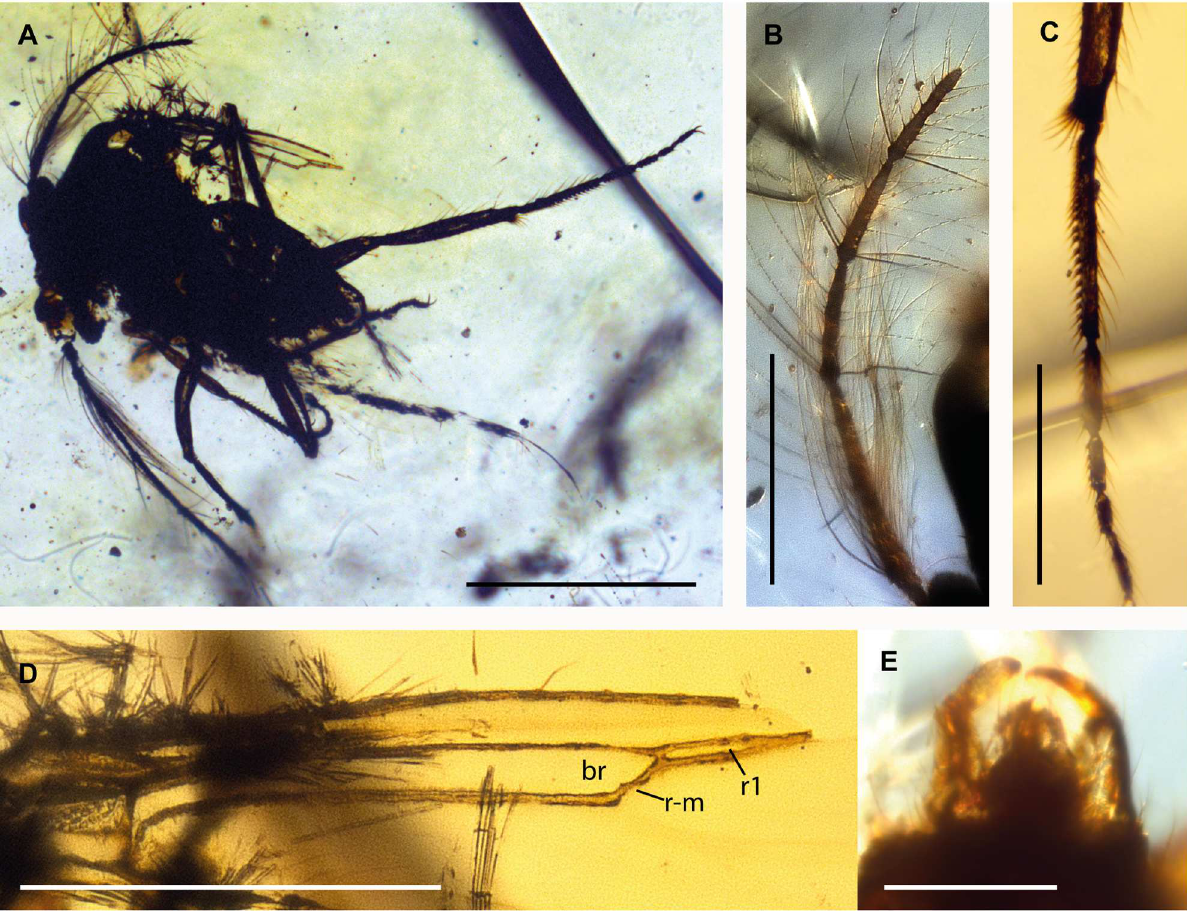
Fig 5. Meunierohelea cambayana n. sp. from early Eocene Cambay amber, holotype male, no. Tad-507. A . Habitus. B . Flagellum. C . Tibia and tarsus of hind leg. D . Radial sector of wing with cell r 1 . E . Male genitalia, dorsal view. Scale bars A: 0.5 mm, B-D: 0.2 mm, E: 0.1